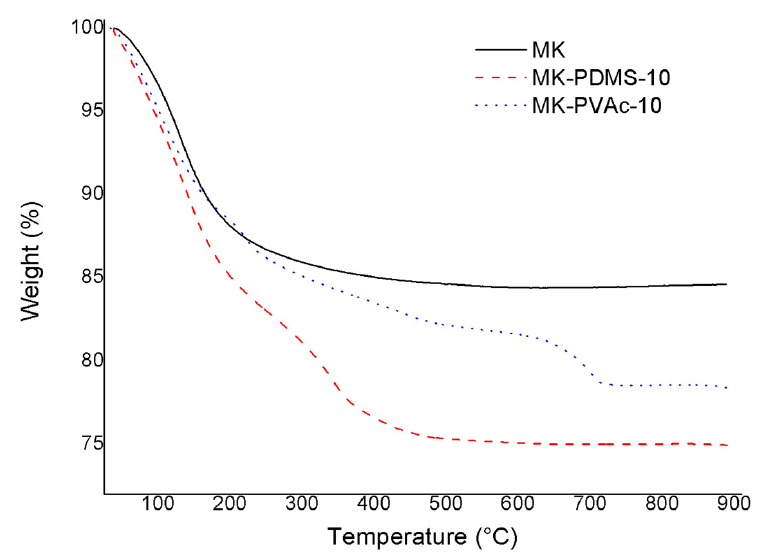
Figure 1. TGA curves of MK (black continuous line), MK-PDMS-10 (red dashed line), and MK- PVAc-10 (blue dotted line) geopolymer samples.